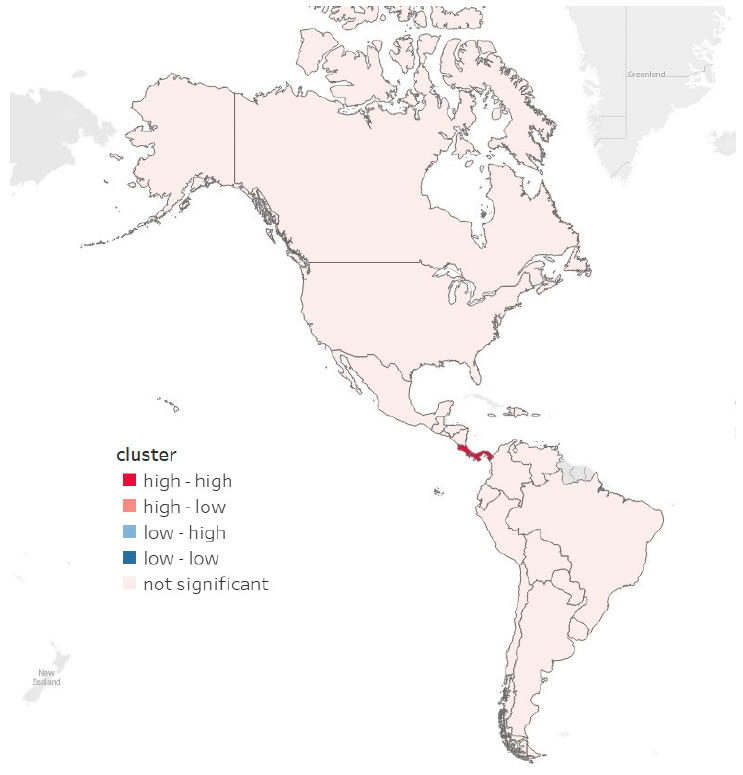
Figure 10. ETI cluster map in North and South America.